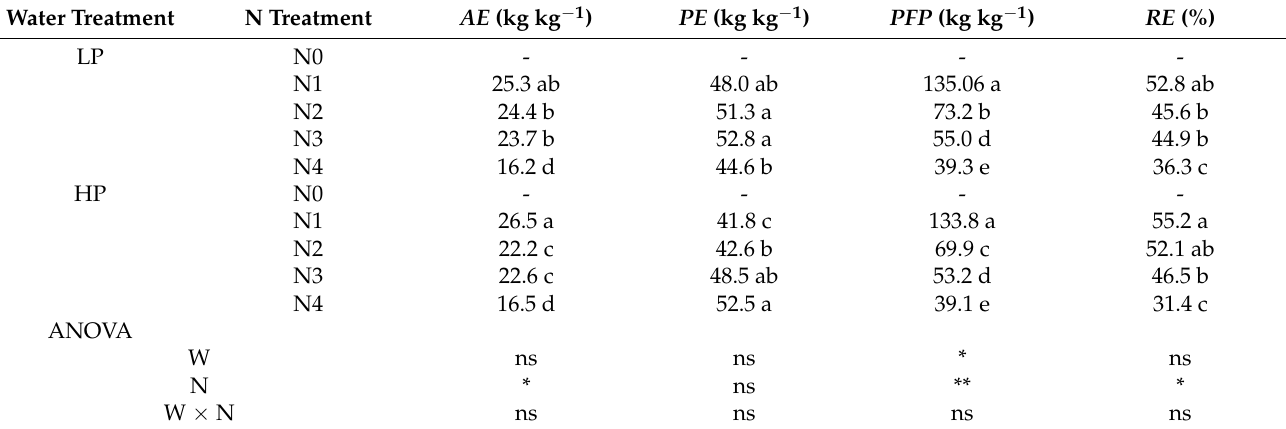
Table 4. Agronomic N use efficiency ( AE ), physiological N use efficiency ( PE ), partial factor produc- tivity of N ( PFP ), and apparent recovery efficiency of N ( RE ) under different water and N treatments. Water